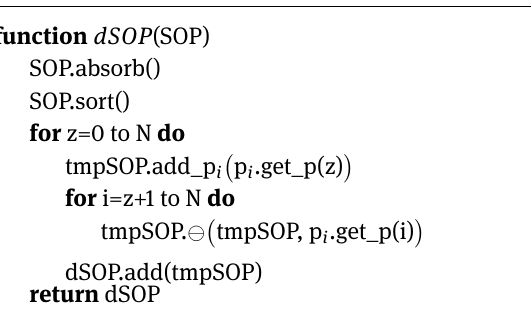
Table 1: Pseudo-Code of the Algorithm ORTH[ ⊖ ] function dSOP (SOP)